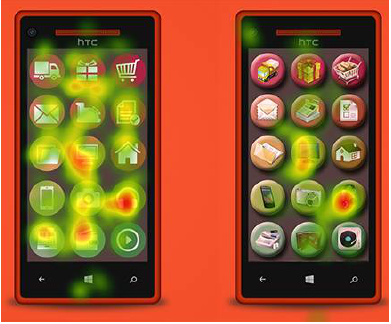
Figure 11. Generated heat map of the two designs.